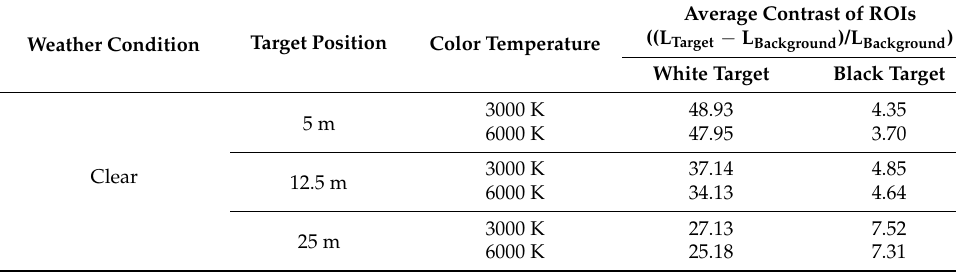
Table 5. Average contrast of ROI in clear